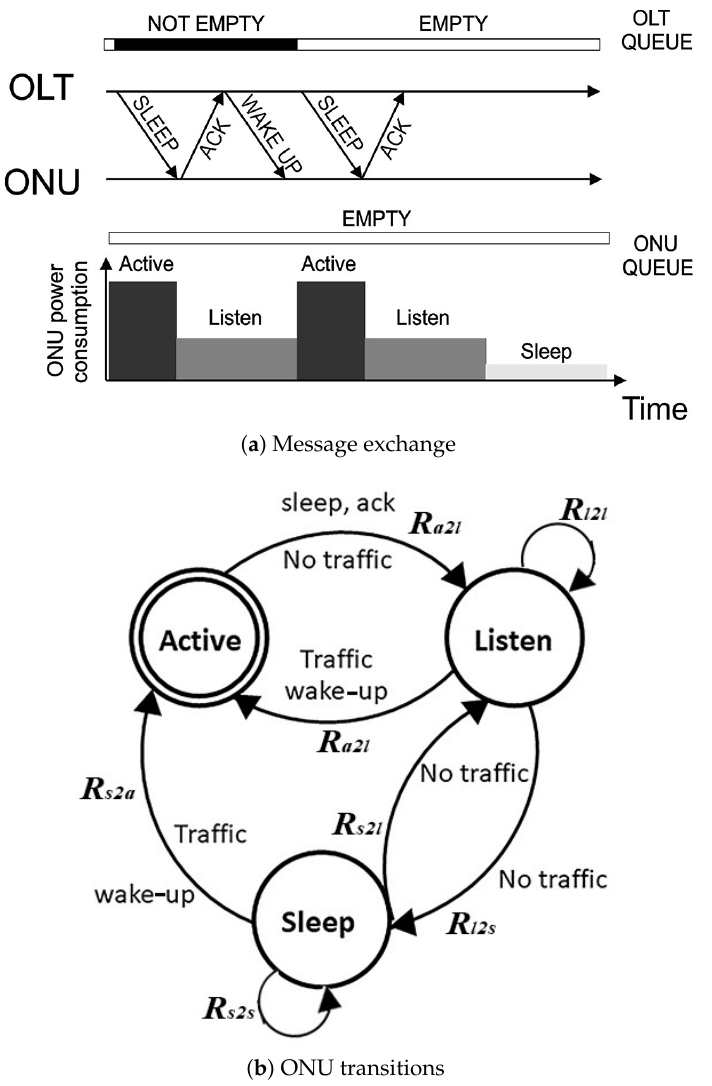
Figure 2. Message exchange of the energy-aware mechanism and ONU transitions between its states while using the Wake-up mechanism.